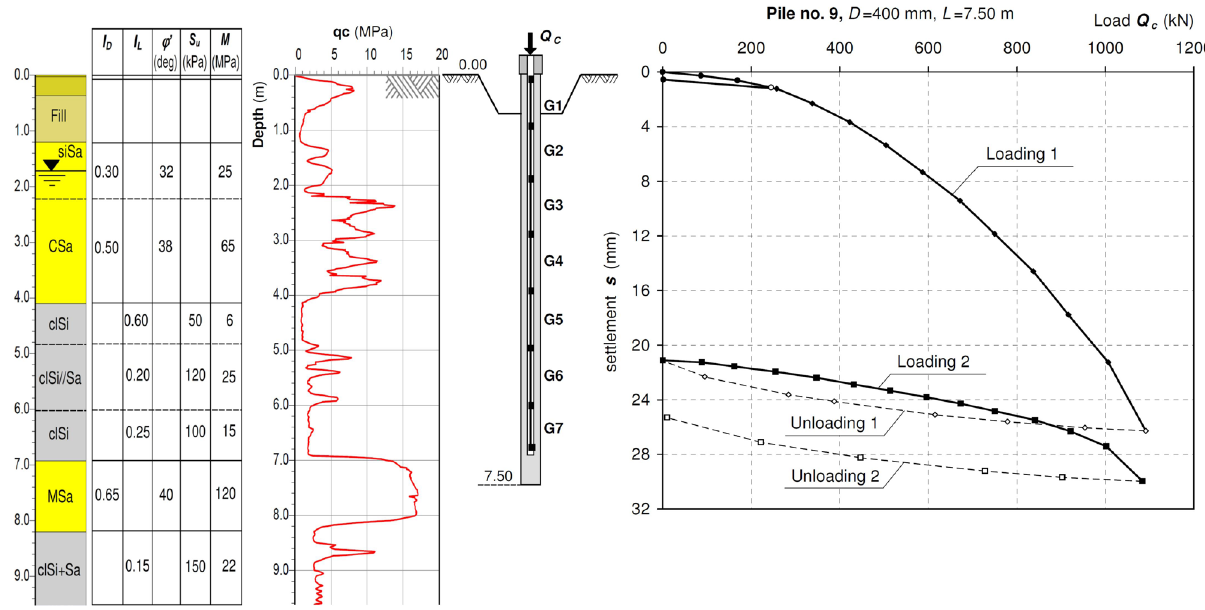
Figure 11: Pile no. 9, basic result of the load